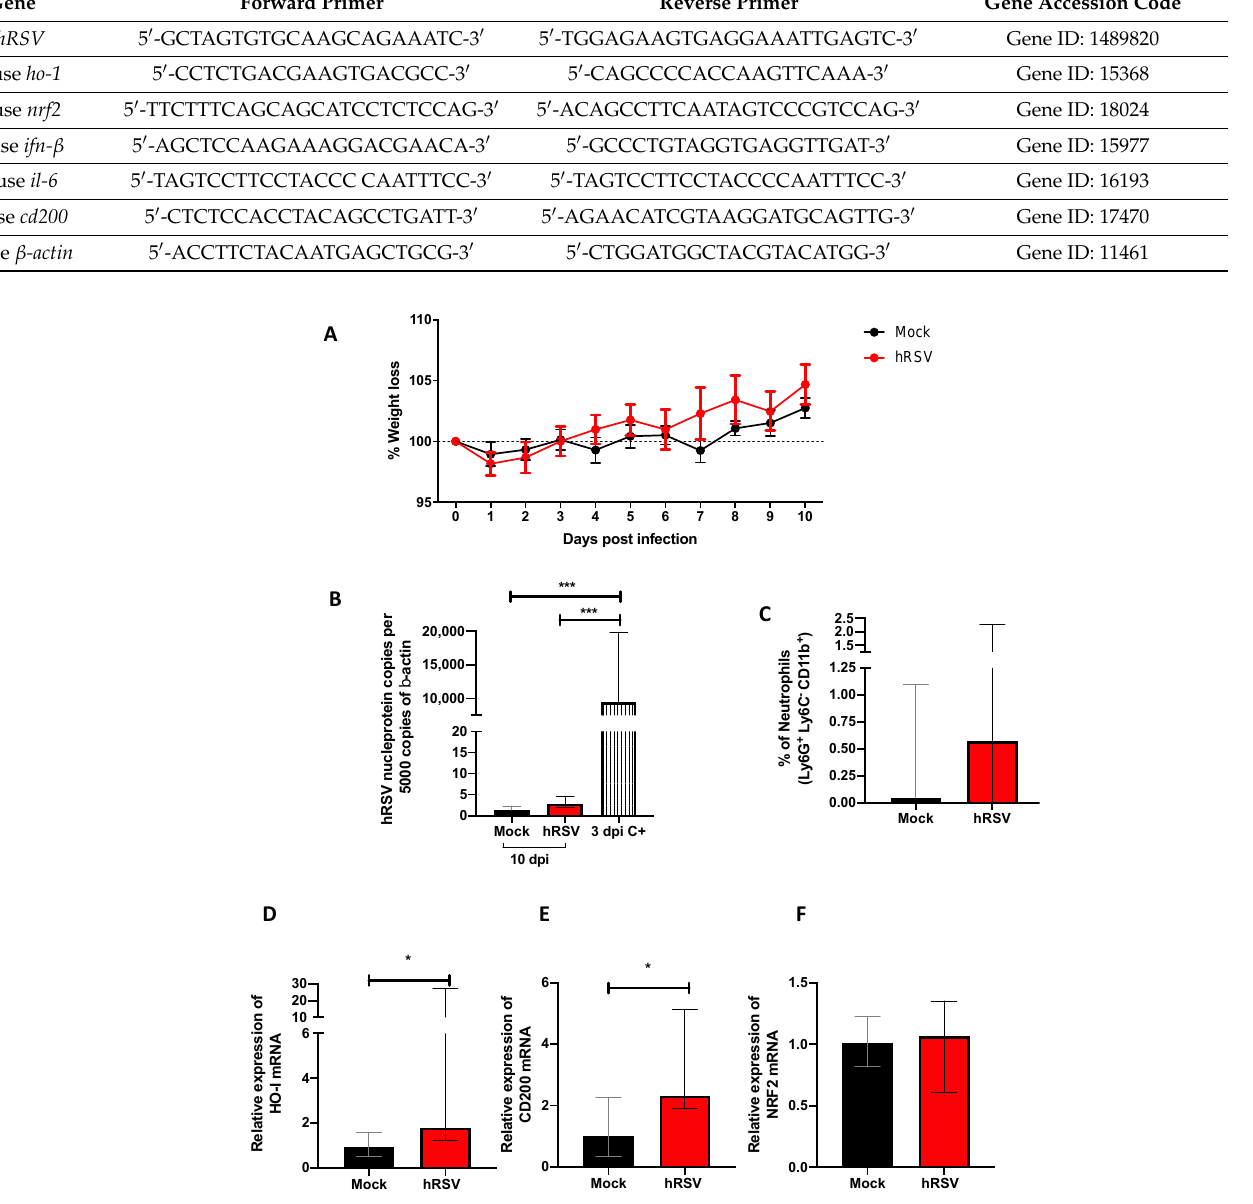
the kinetics of the weight curves of Figure 2A and Supplementary Figure S2A. Figure 1A